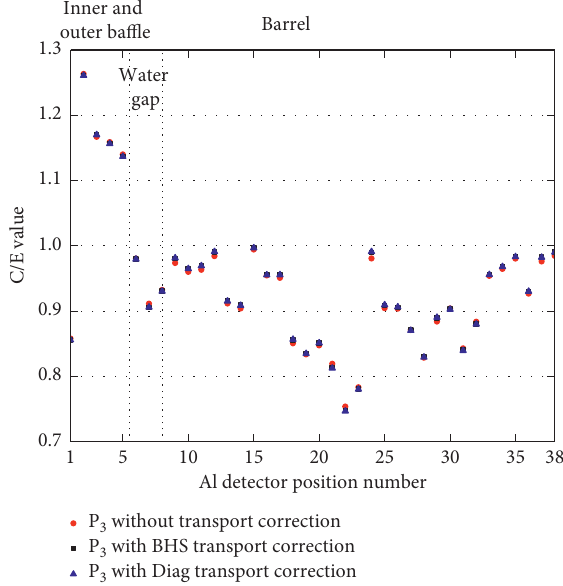
Figure 22: Comparison of P 58 Ni(n,p) 24 Na